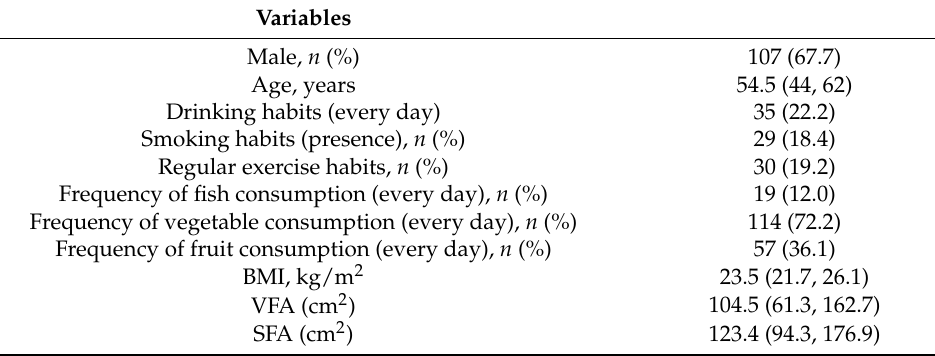
Table 1. Characterization of the study participants ( n =